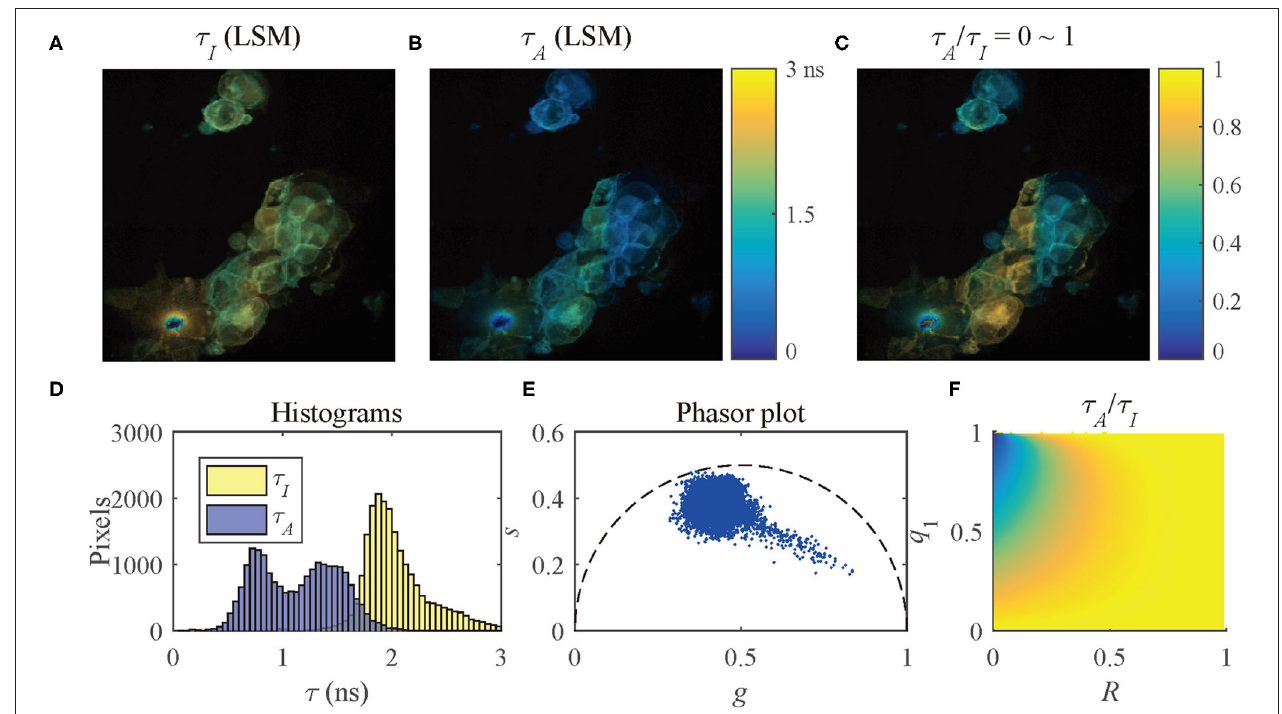
FIGURE 9 | (A) τ I -intensity image, (B) τ A -intensity image evaluated by LSM-2, (C) τ A /τ I ratio image, (D) histograms of τ I (yellow) and τ A (blue), (E) phasor plot, and (F) distribution of τ A /τ I of the selected pixels in (C)